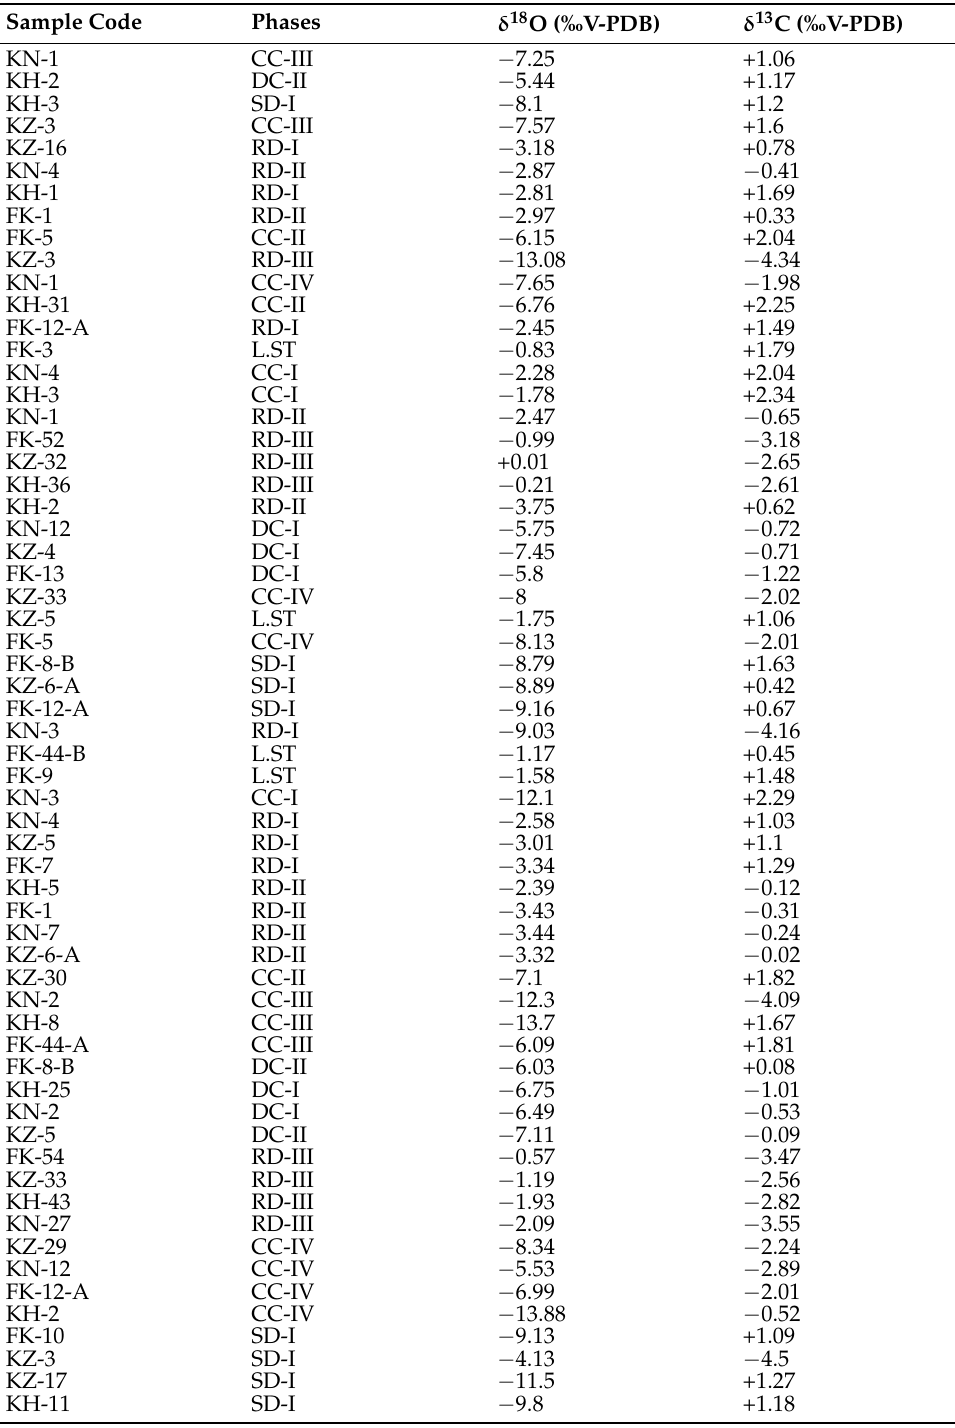
Table 2. Stable isotopic composition of the representative samples from different dolomite and calcite phases. Sample